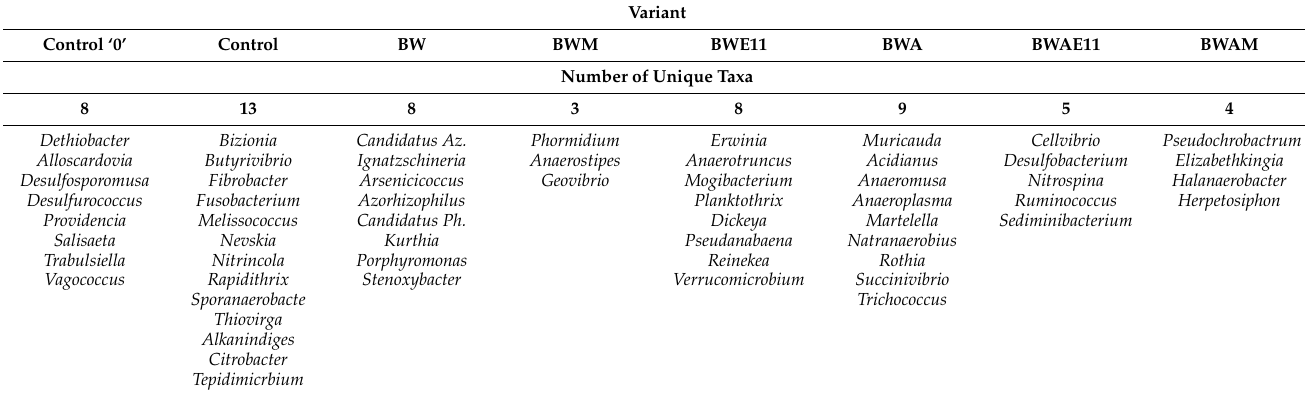
Table 3. Unique bacterial taxa in individual experimental variants. Variant